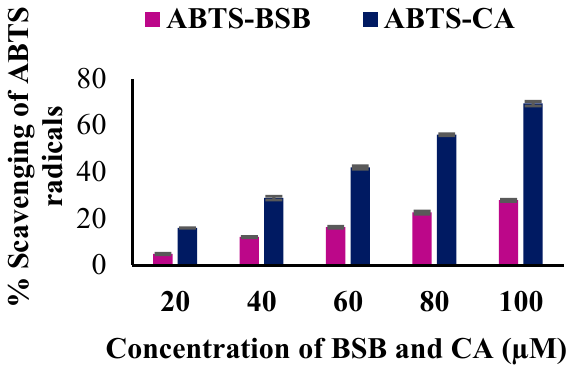
Figure 10. The in vitro scavenging e ff ects of BSB and CA on ABTS radicals (Total antioxidant activity). Each column is the average of triplicate